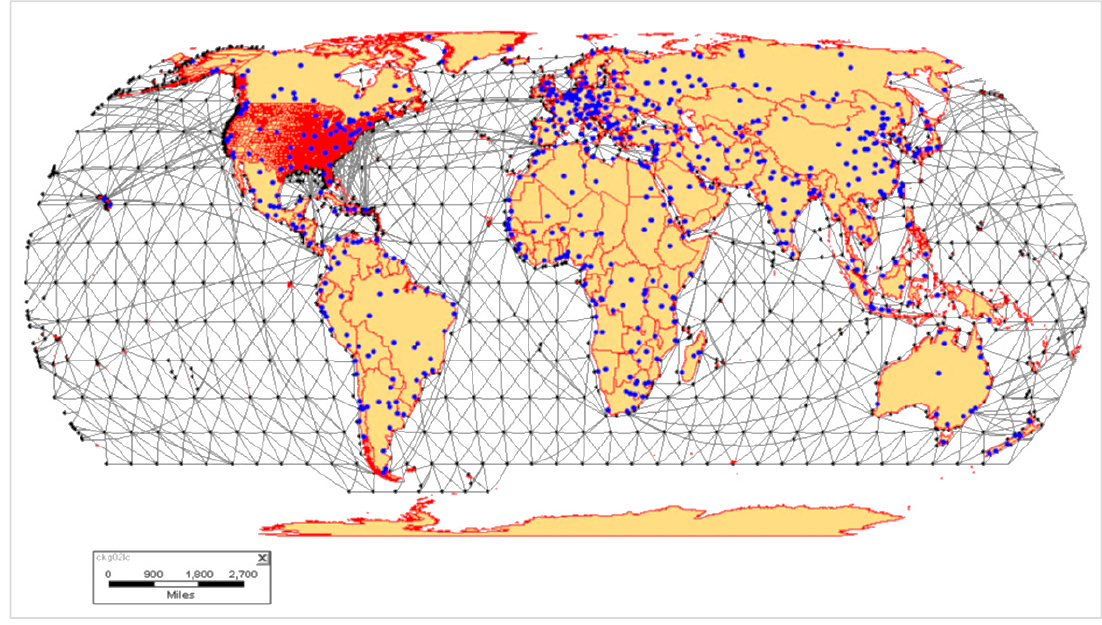
Figure 1. Global maritime network with ports, routes, and countries.